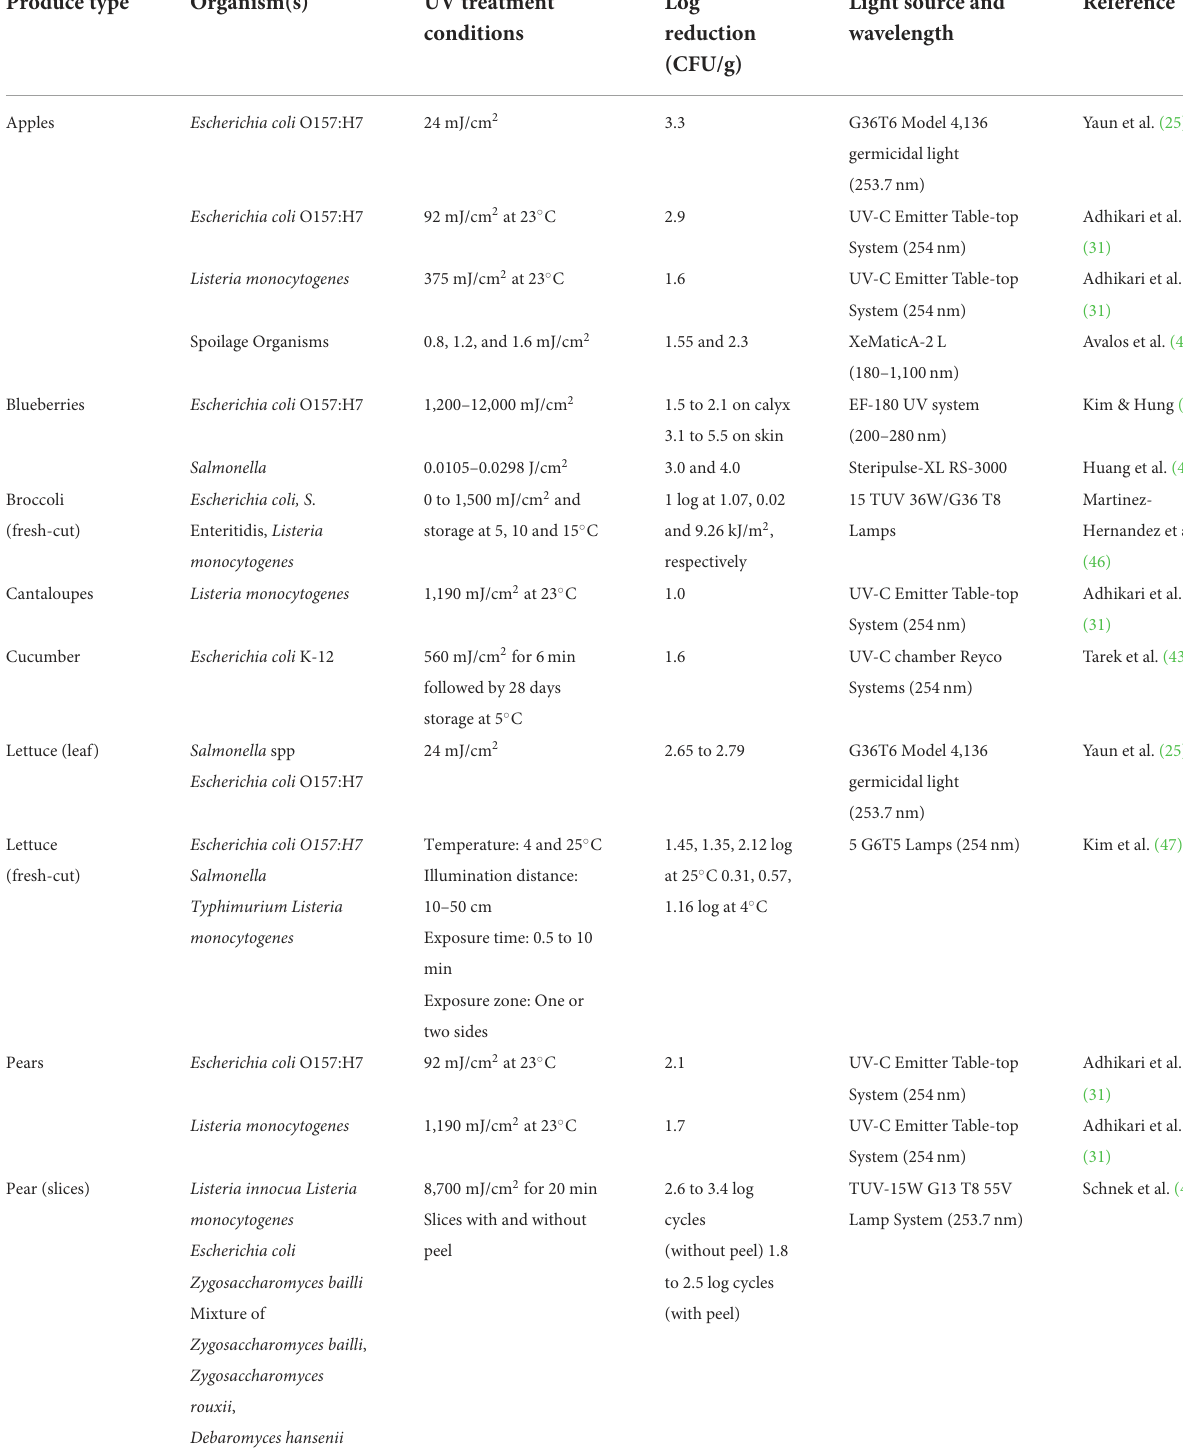
TABLE 1 Studies on UV-C treatment of fresh and fresh-cut fruits and vegetables. Produce